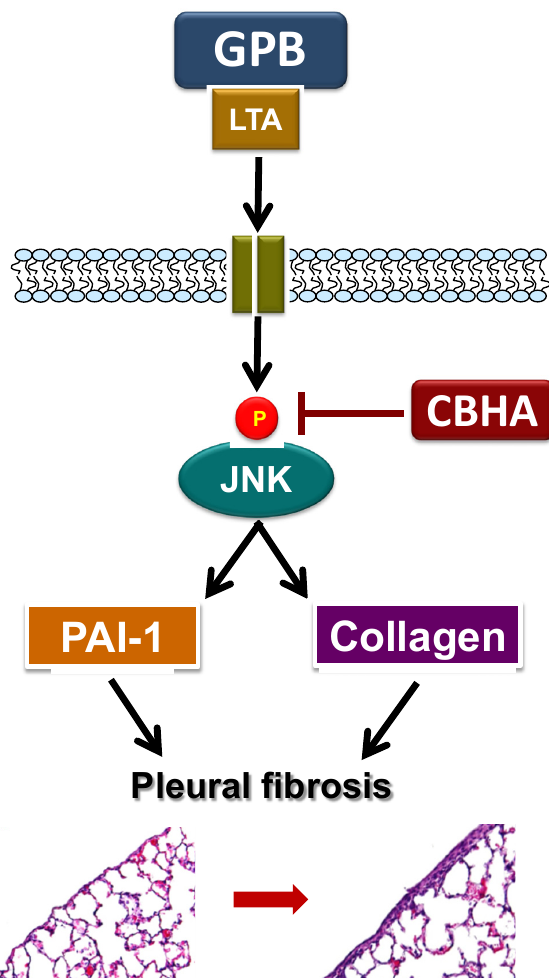
Figure 6. Graphic abstract illustrates that CBHA ablates LTA–induced PAI-1 and collagen production in human pleural mesothelial cells via down-regulating the JNK pathway, and attenuates pleural fibrosis (see text for more explications). Single arrow, established pathway. GPB, Gram-positive bacteria; LTA, lipoteichoic acid; CBHA, m-carboxycinnamic acid bis-hydroxamide; JNK, c-Jun N-terminal kinases; ○ P , phosphorylated.